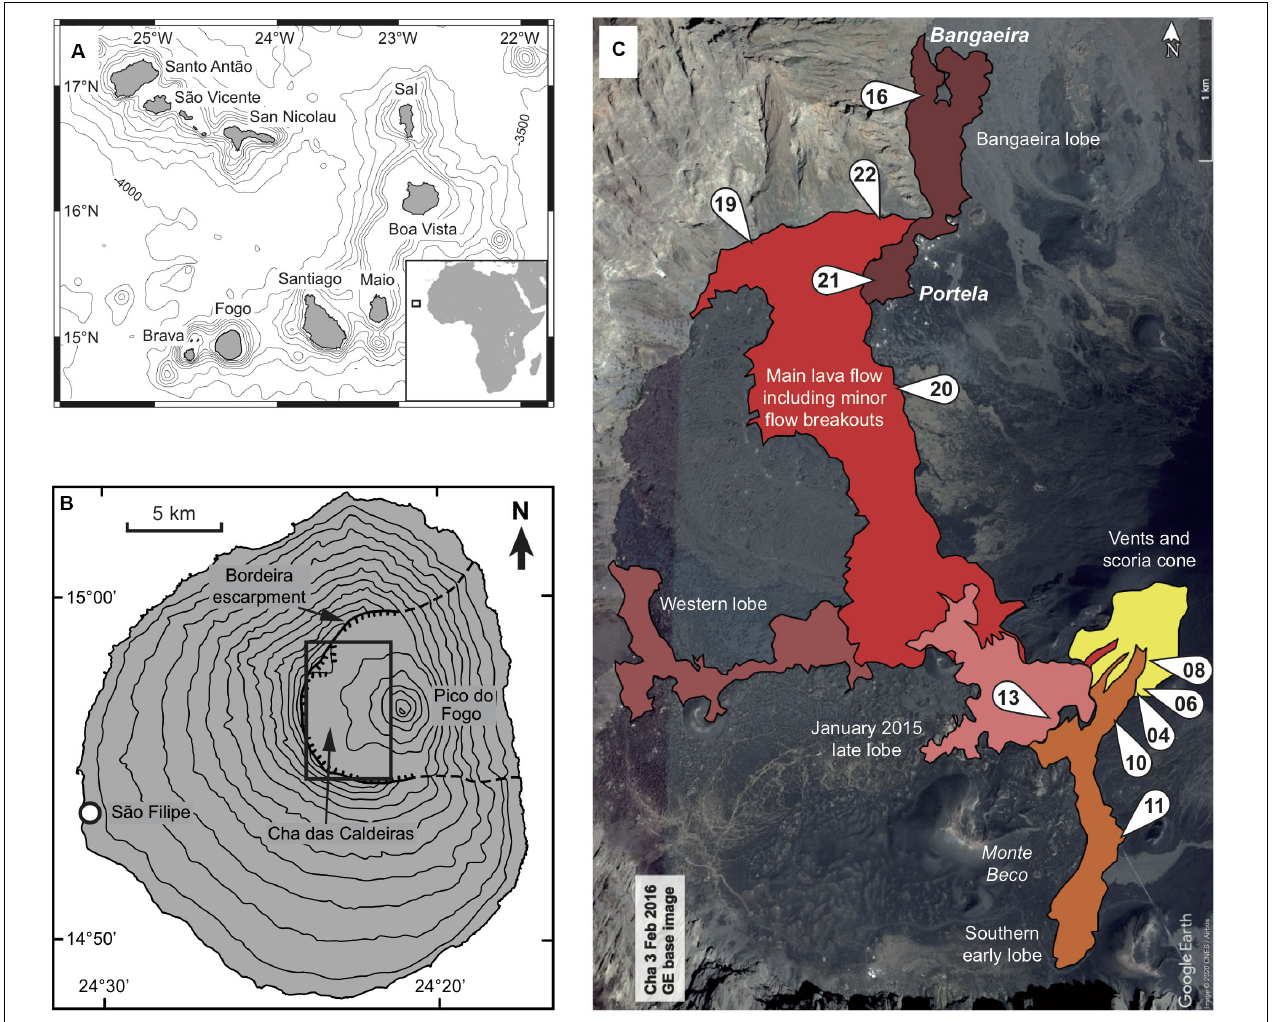
FIGURE 1 | (A) Map of the Cape Verde Islands with 500 m isobaths, and (B) overview map of Fogo with 200 m contours. (C) Detail map of the area outlined in (B) showing the extent of the lava flows emplaced during the 2014–2015 eruption. Numbers indicate the sample localities (e.g., 04 refers to sample SD04). Base map by Google, using data from